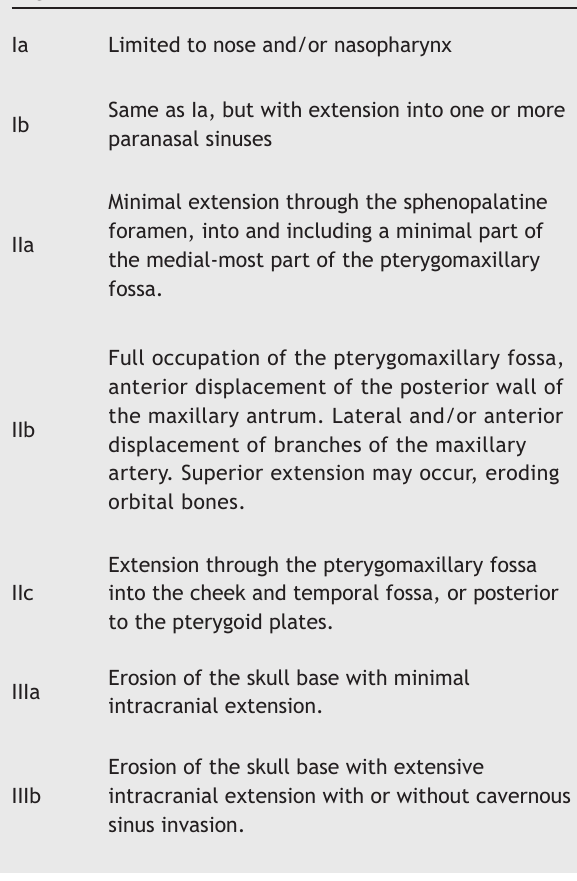
Table 2 Radkowski classification of juvenile